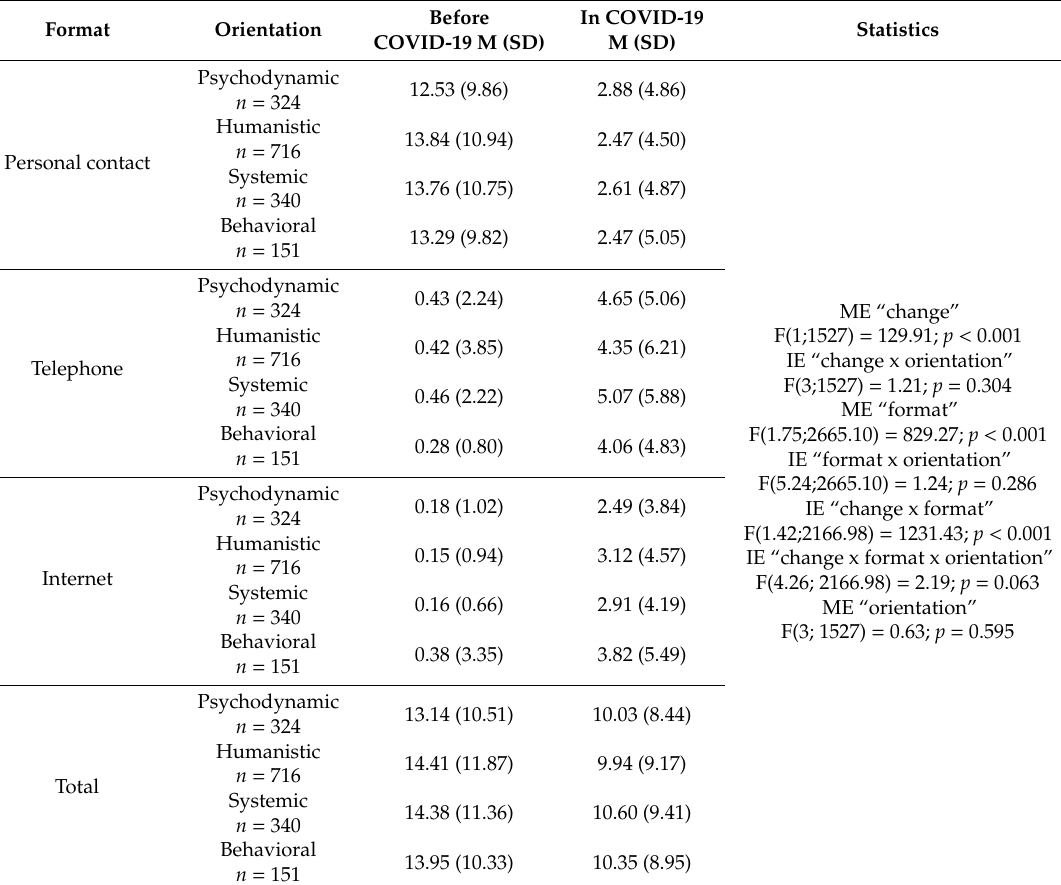
Table 1. Results of the repeated measures analyses of variance